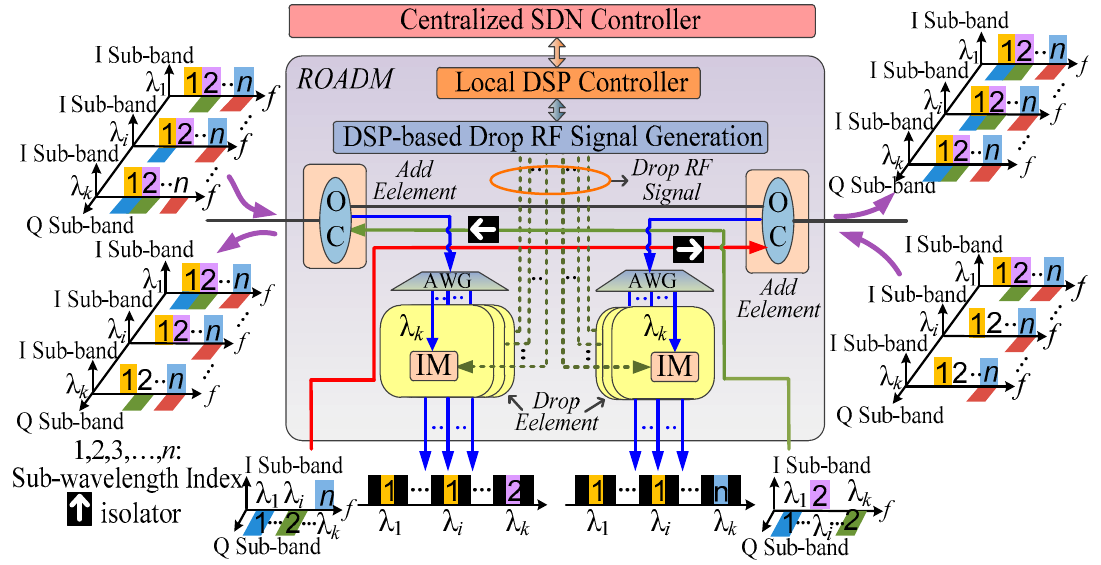
Figure 7. Architecture of DSP-enabled soft-reconfigurable optical add/drop multiplexer (soft-ROADM).